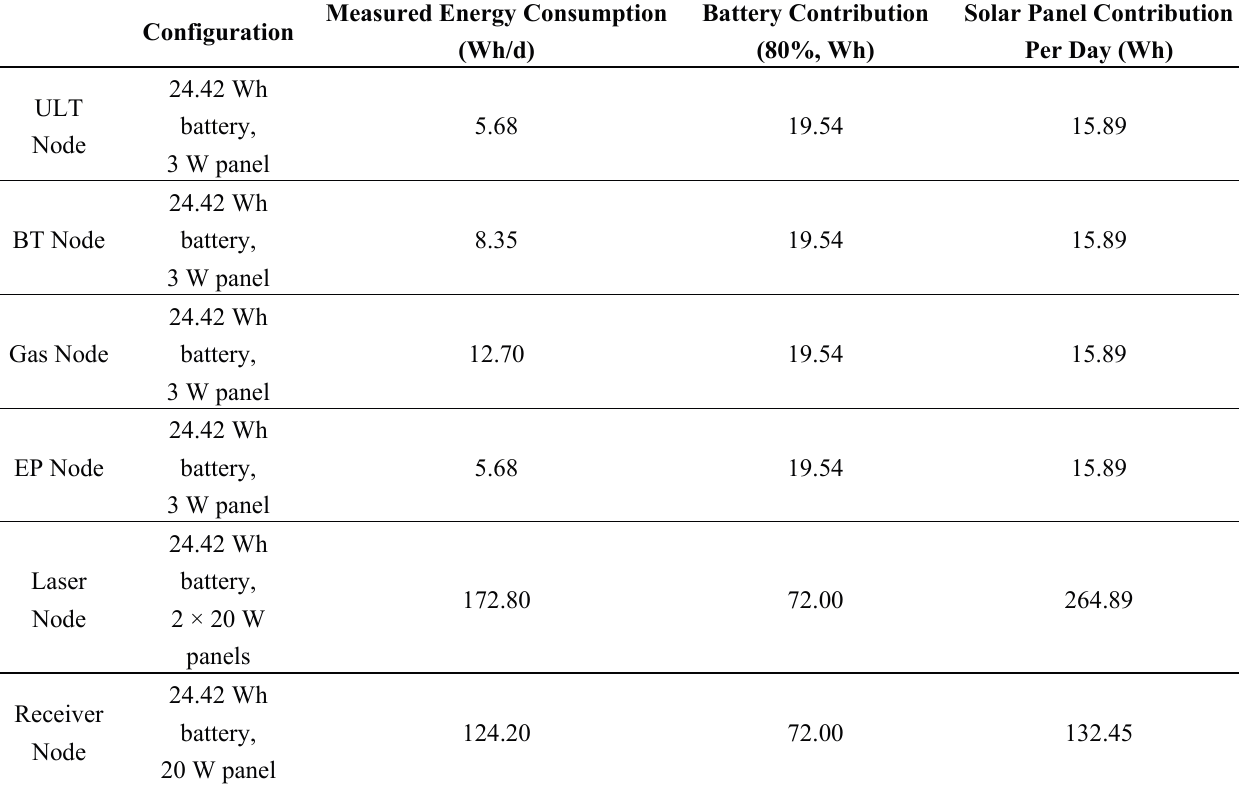
Table 2. Energy consumption of the UIS